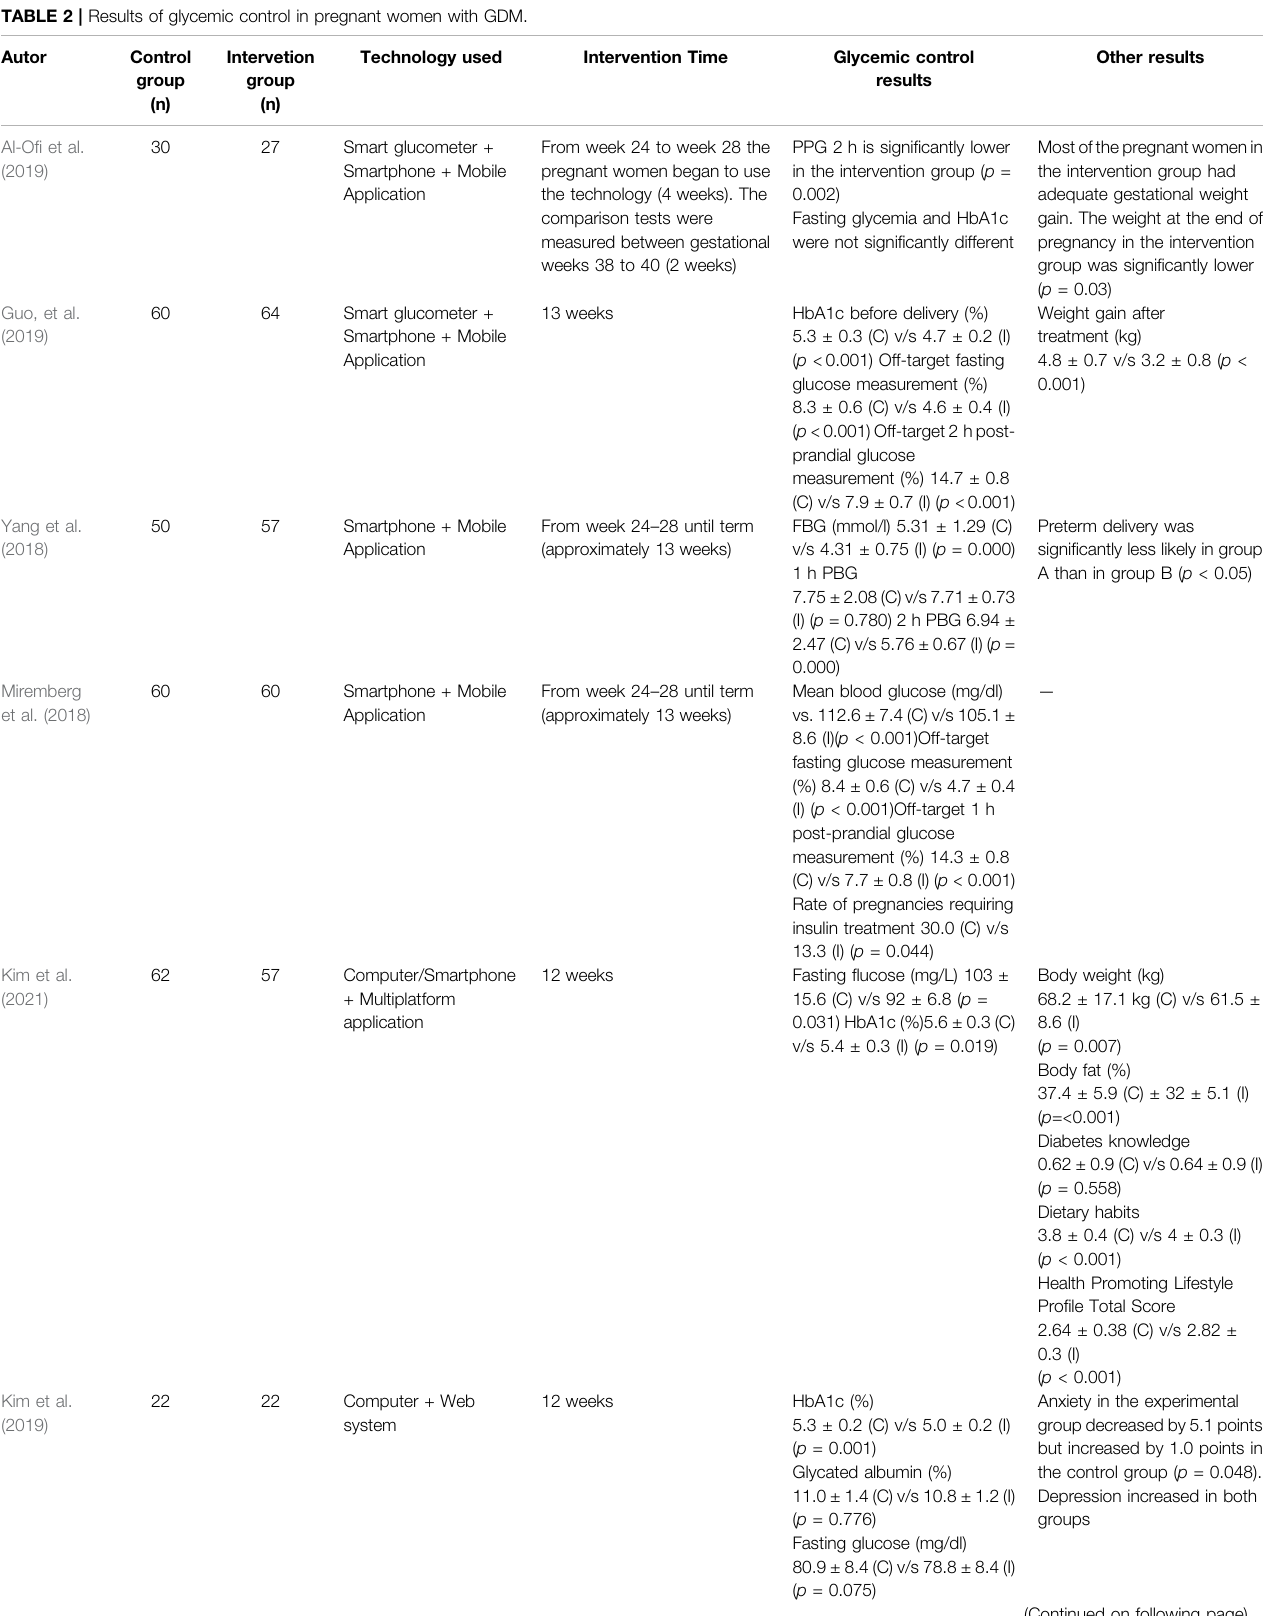
TABLE 2 | Results of glycemic control in pregnant women with